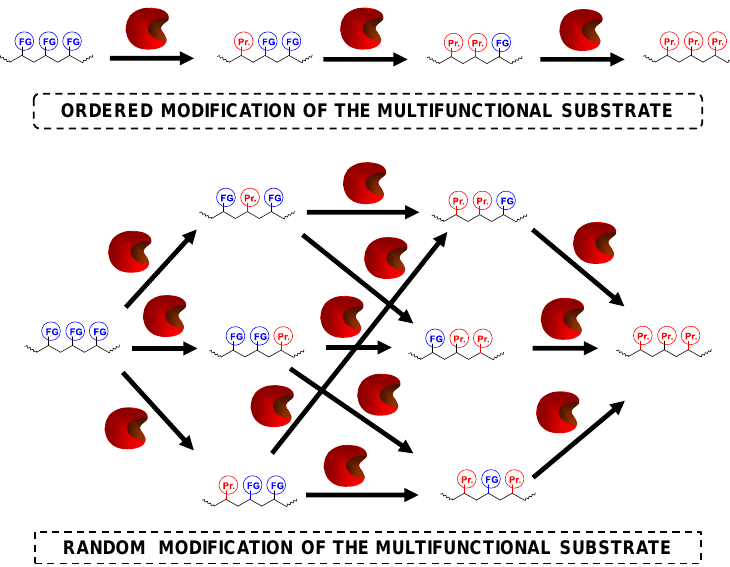
Figure 5. Ordered or random enzymatic modification of multifunctional substrate.